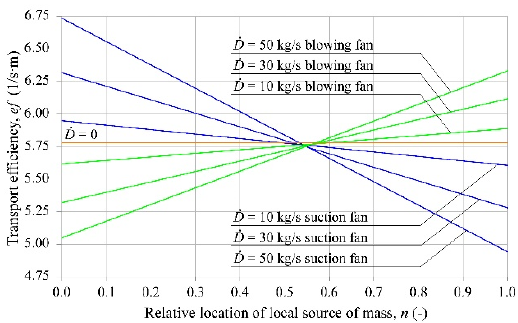
Figure 3. Duct gas transport efficiency in the presence of a local source of mass.